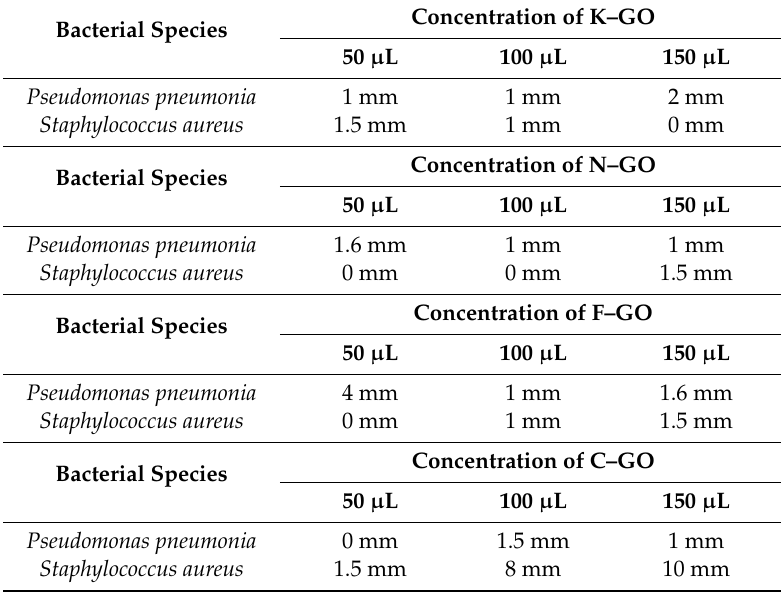
Table 4. Zones of inhibition (ZOIs) of antimicrobial activity for K–GO, N–GO, F–GO, and C–GO of various concentrations in methanol solvent (50, 100, and 150 µ g /